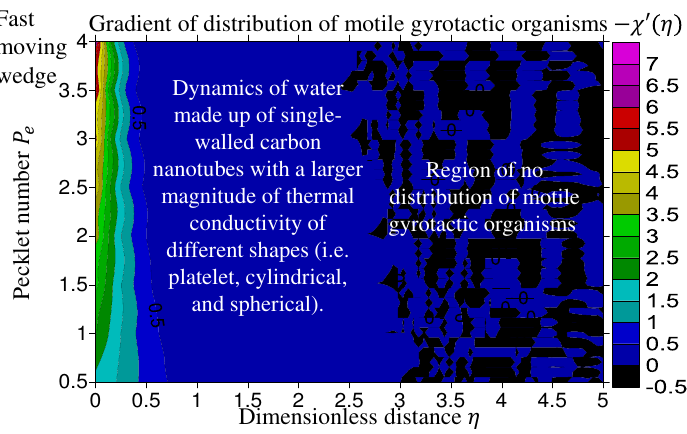
Figure 15. Variation of the gradient of distribution of motile gyrotactic organisms − χ (cid:48) ( η ) within the entire domain on a static wedge (i.e., λ = 0) with P e and m = 0.1.